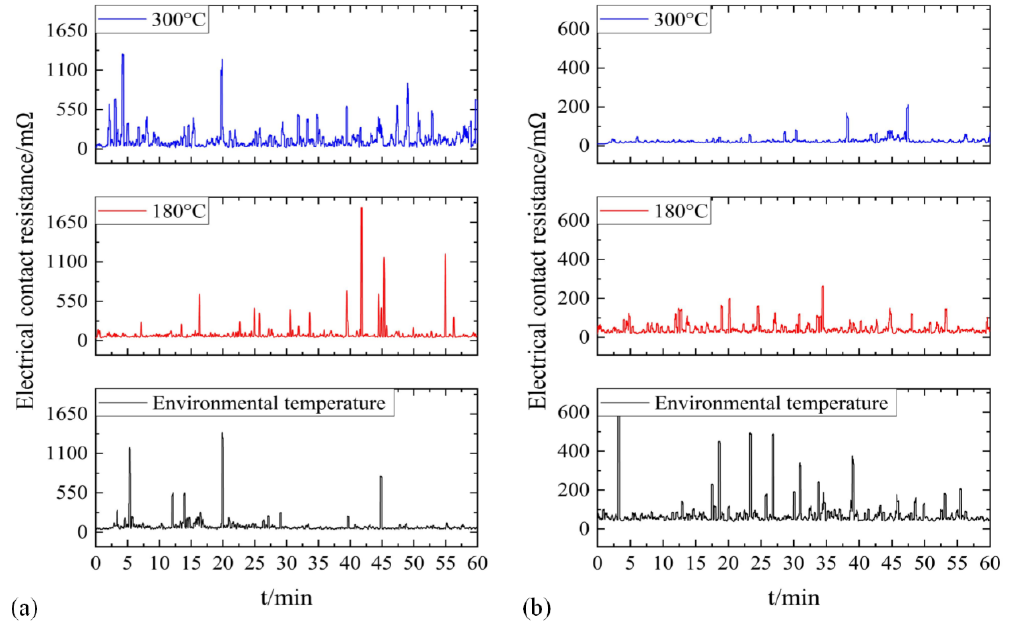
Figure 4. Effect of temperature on the DECR of the C-Cu contacts: ( a ) at 10 A and ( b ) at 80